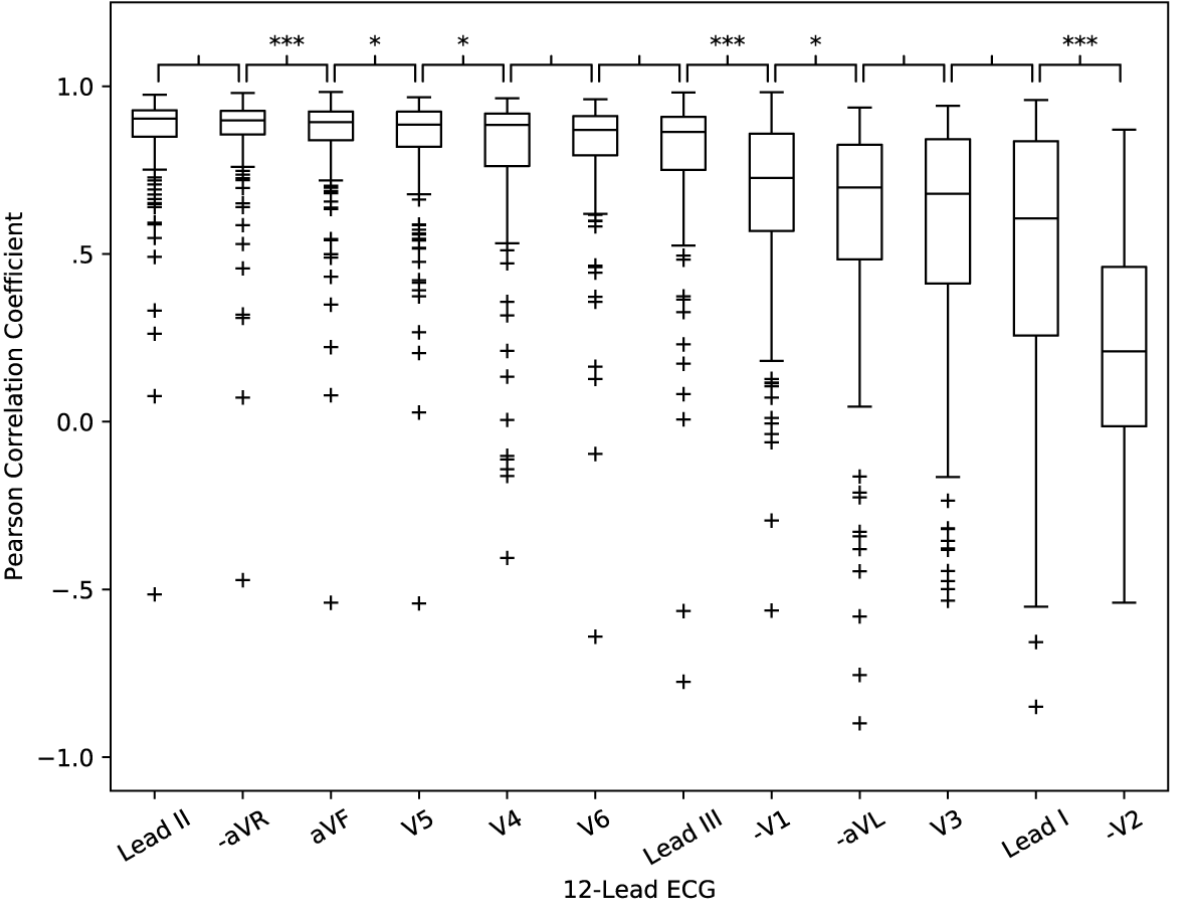
Figure 5. Box plots across normative recordings (N=140) show the correlation between the bECG and the standard ECG leads. Leads aVR, V1, aVL, and V2 have been inverted to facilitate visual comparison. Leads are organized from left to right by highest to lowest correlation. The top 3 correlated leads were Lead II, aVR, and aVF with median correlations of .904, .899, and .893, respectively. Statistical significance was tested using a paired Student